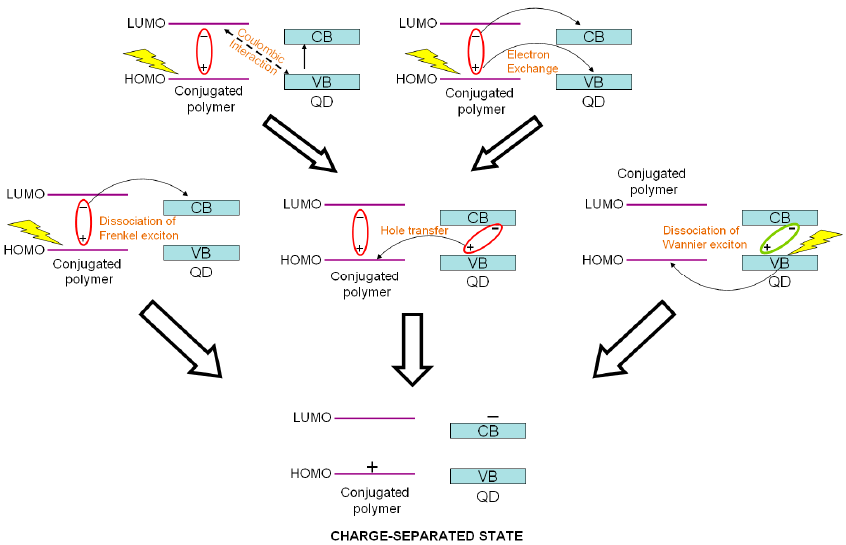
Figure 8. Charge separation mechanisms in polymer–quantum dot bulk heterojunction solar cells. Reprinted from [45] with permission from Elsevier.